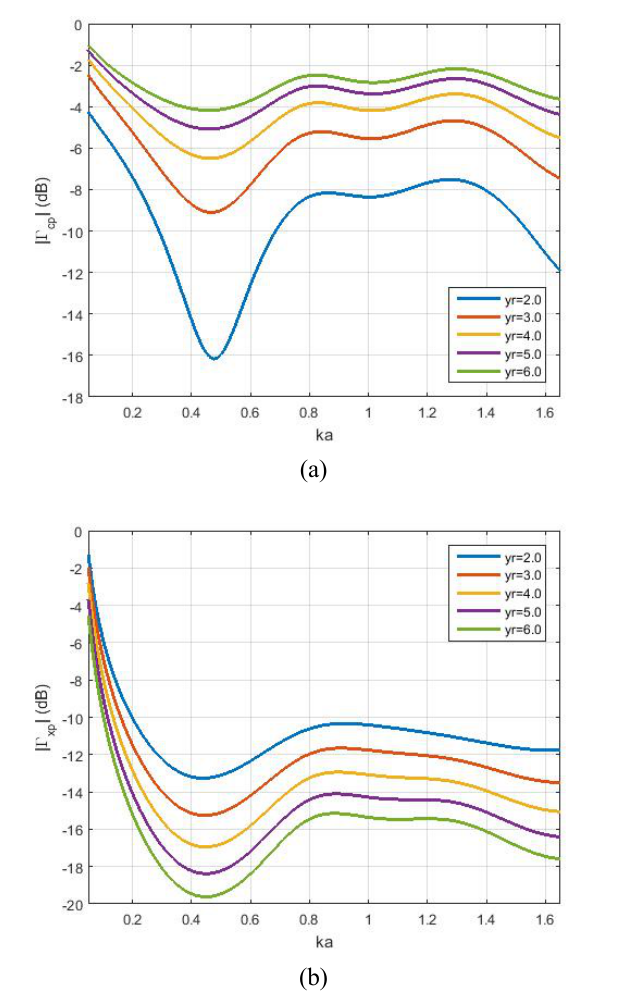
Figure 6: Variations of the reflection coefficient magnitudes with ka for buried PEMC circular cylinders of radius a , with d =2.5 cm, ρ 0 =3.0 cm, and ν =45 0 , for five different values of y r ; (a) co-polar coefficient; (b) cross polar coefficient.